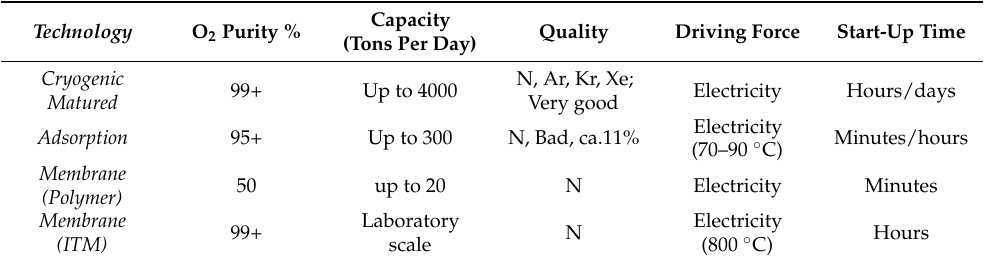
Table 2. Separation technologies of O 2